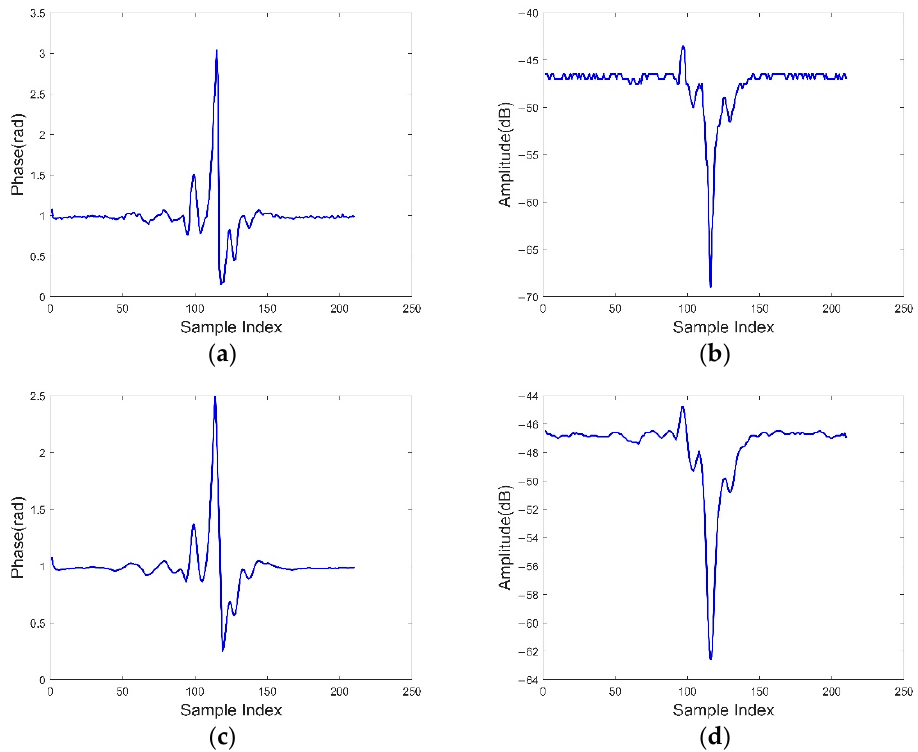
Figure 8. Phase and amplitude before and after data smoothing: ( a , b ) show the raw phase and amplitude; ( c , d ) show the phase and amplitude after processing.